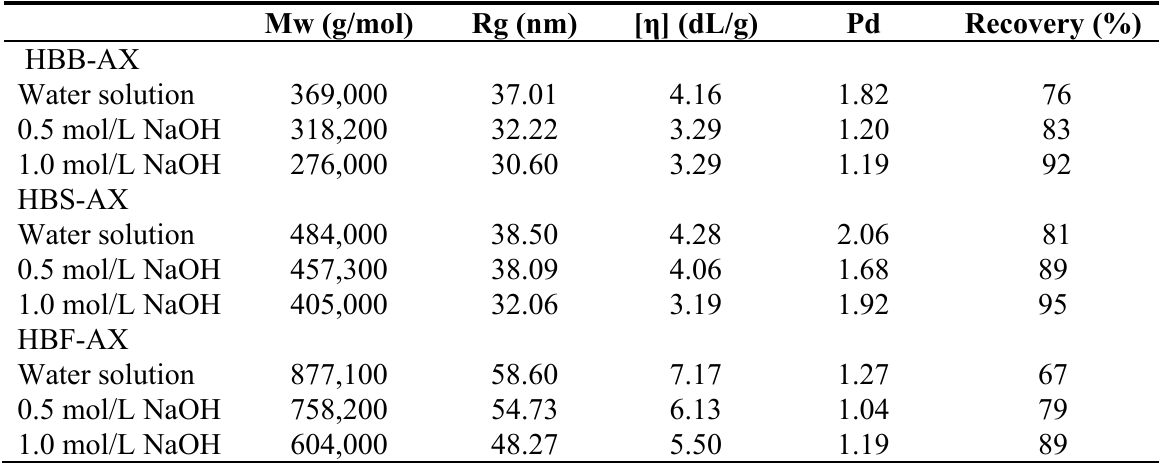
Table 3. Molecular weight (Mw), radius gyration (Rg), intrinsic viscosity [ η ], and polydispersity (Pd) of HBB-AX, HBS-AX and HBF-AX in different